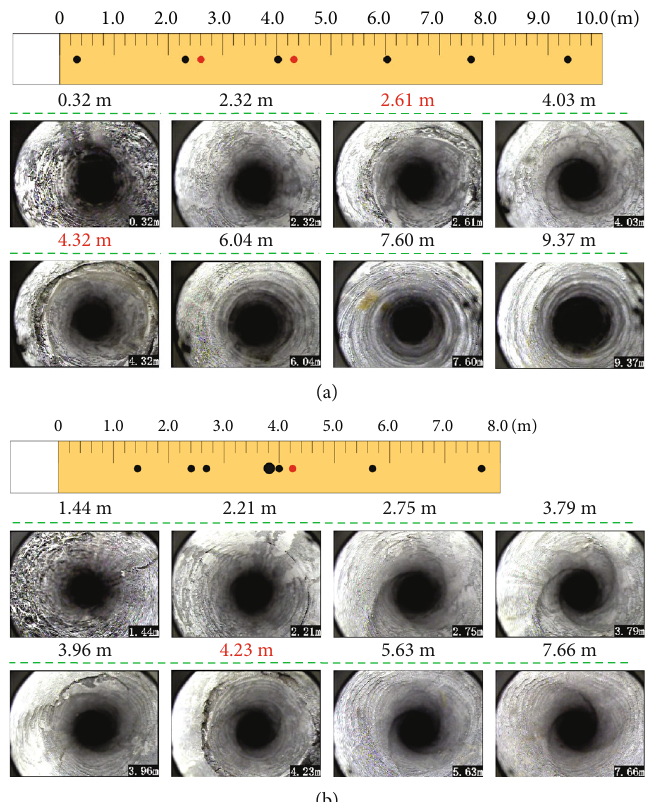
Figure 12: Monitoring results of separation fractures in roof stratum: (a) monitoring results of stations numbered a# and (b) monitoring results of stations numbered